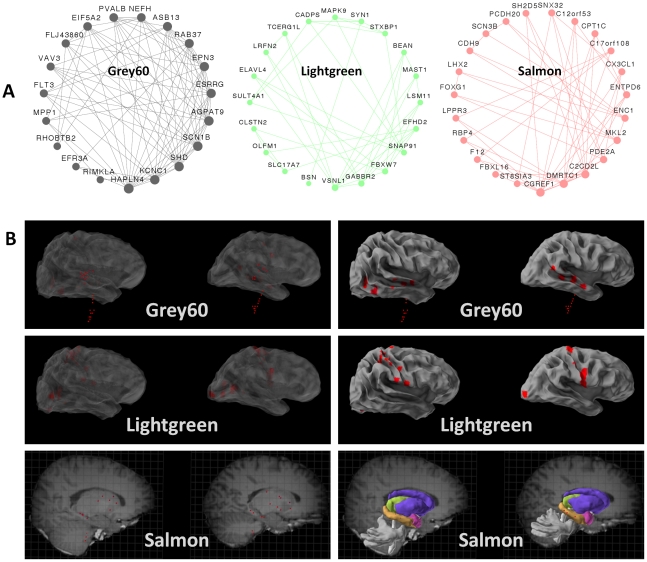
Modules correspond to specific neuronal sub-groups acting in specific regions.(A) For the three neuronal modules, the twenty genes with the most connections out of the top 150 connections in the module are illustrated. (B) For the three neuronal modules, the ten areas showing the highest expression of the module eigengene were visualized using Brain Explorer (http://www.brain-map.org). A superficial view of the brain is shown on the right, and an in-depth view is shown on the left. As some regions were available for only one of the two individuals, the regions are shown in both brains.